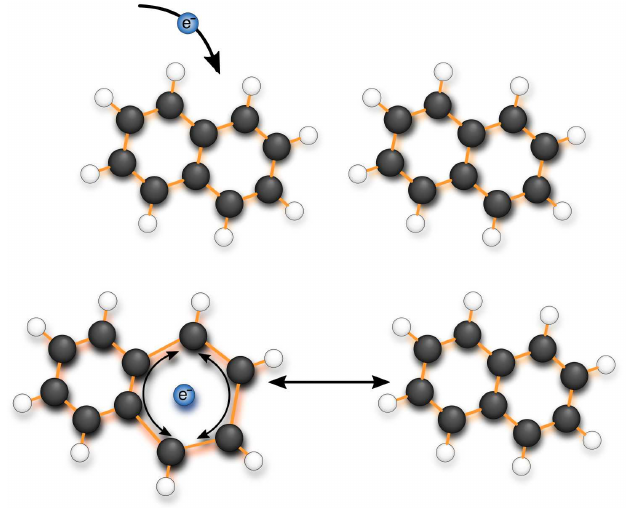
Figure 1. Sketch of the interplay between low-frequency inter-molecular and high-frequency intra-molecular vibrational modes in a crystal of naphthalene. The charge carrier deforms the benzene ring when it is on the molecule. Moreover, the charge carrier displaces two neighbor molecules when it